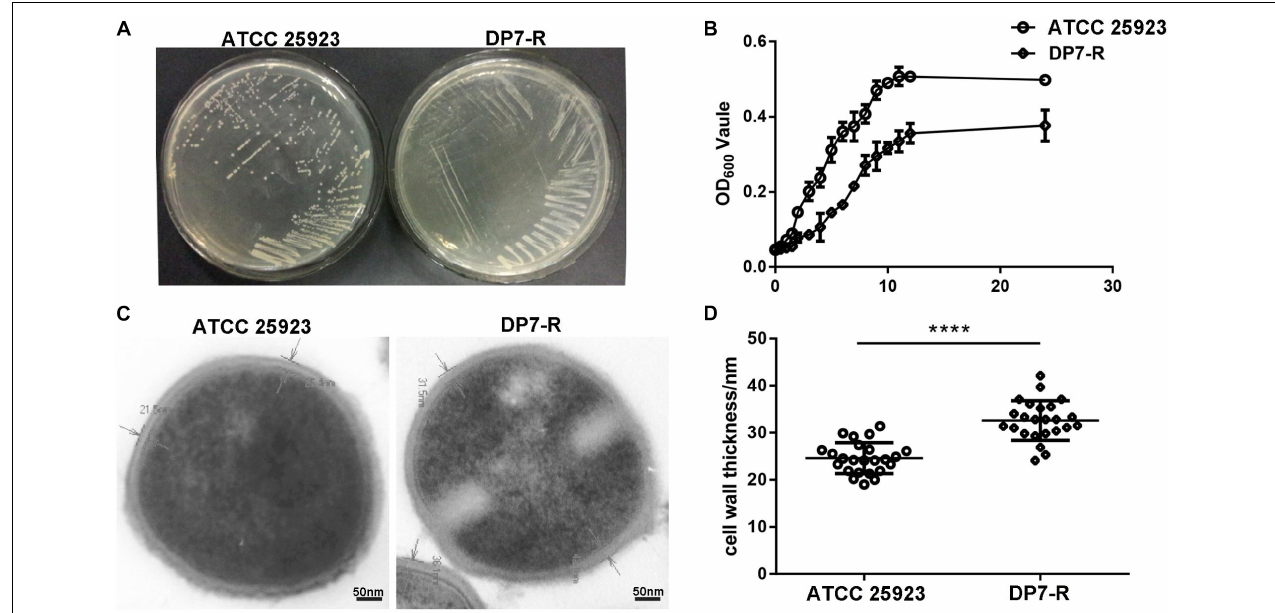
FIGURE 6 | DP7-R showed a slower growth rate and thicker cell wall compared with wild-type DP7-sensitive strains. (A) Comparison of wild-type S. aureus ATCC 25923 and DP7-R. (B) DP7-R shows a slower growth rate than ATCC 25923. (C) The cell wall thicknesses of S. aureus ATCC 25923 and DP7-R. (D) Cell wall thickness statistics in different cells (approximately 20 cells) in several fields of view ( n ≥ 3; ∗∗∗∗ p <